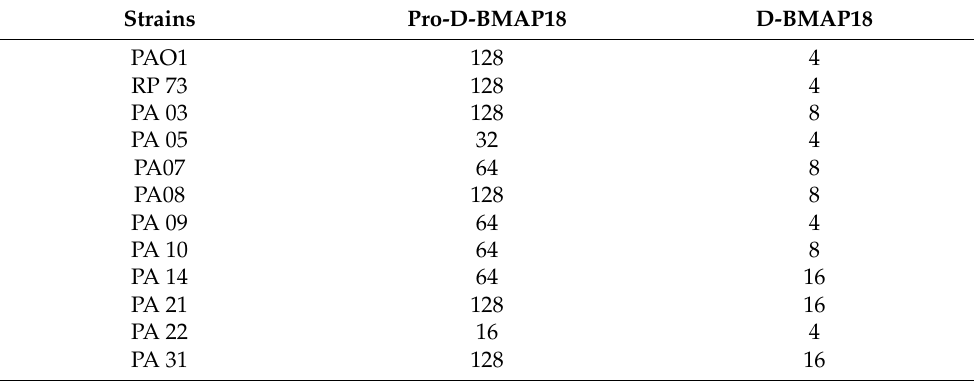
Table 1. MIC ( µ g/mL) values of D-BMAP18 vs. Pro-D-BMAP18 against P. aeruginosa strains. Strains